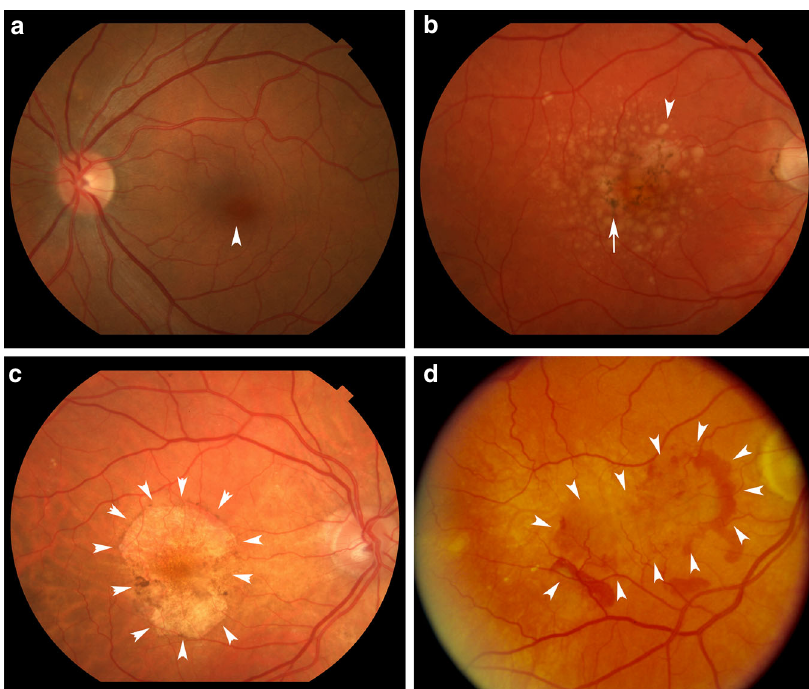
Fig. 1 Spectrum of AMD. a Fundus photograph of a normal left macula. Arrowhead points to the fovea. b Right eye with intermediate, dry AMD. Arrowhead points to a typical large druse while arrow points to RPE hyperpigmentation. c Right eye with geographic atrophy. Arrowheads outline the area of GA. d Right eye with neovascular AMD. Arrowheads outline the area of choroidal neovascularization that is partially outlined by subretinal